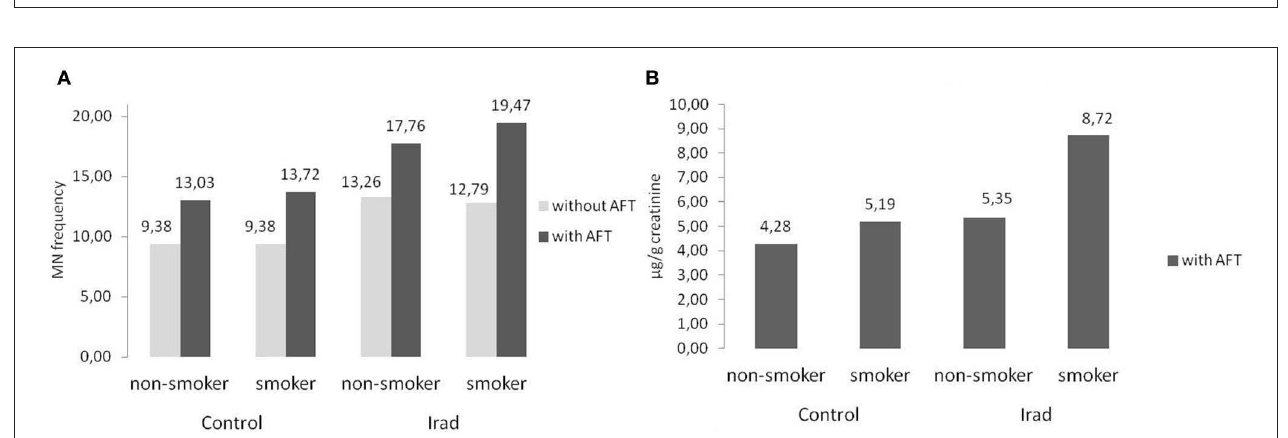
FIGURE 6 | Influence of participants’ smoking status on micronucleus frequency (A) and 8-OHdG values (B) in hospital workers exposed to ionizing irradiation. MN, micronucleus frequency; 8-OHdG, 8-hydroxy-2 ′ -deoxyguanosine value.